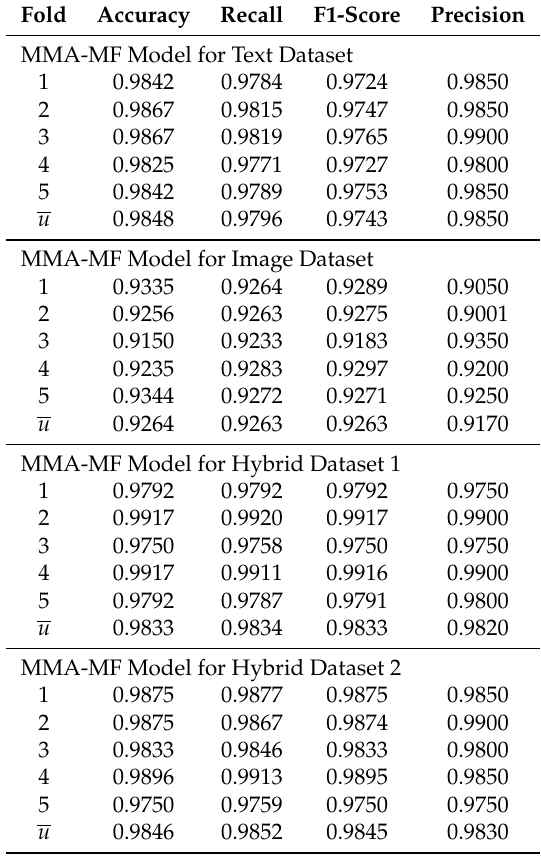
Table 7. Experimental results in 5-fold cross-validation for the MMA-MF